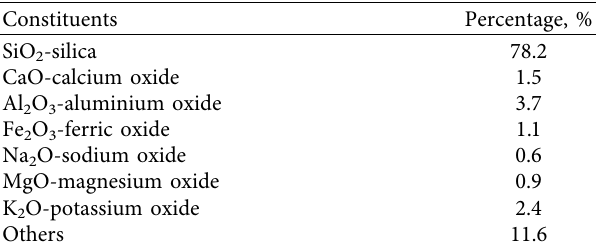
Table 8: Chemical composition of rice husk ash (RHA) from X-ray (ASTM D5381) fuorescence analysis.